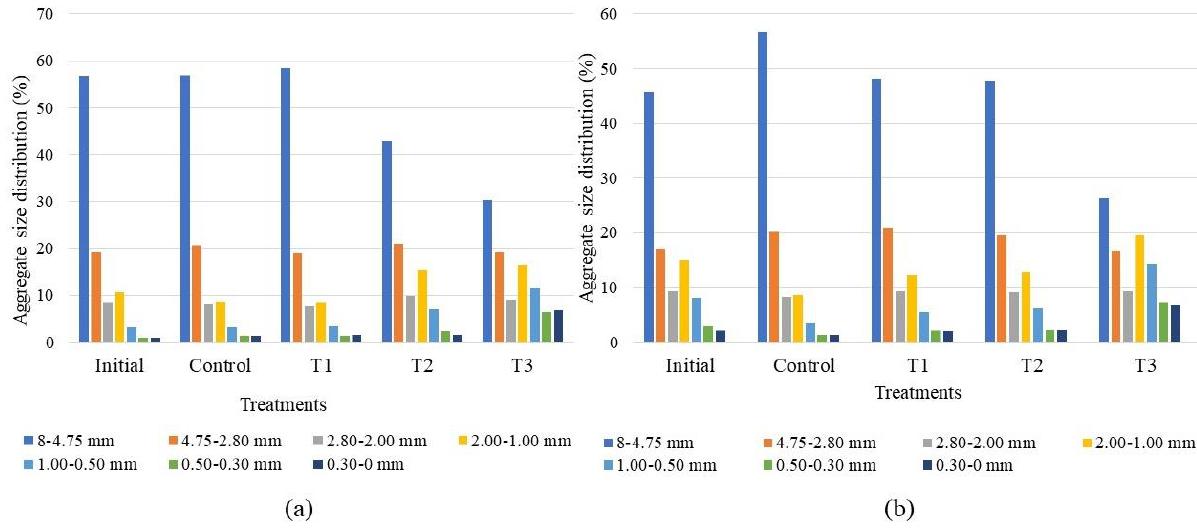
Figure 3. Distribution of aggregate size (%) in (a) hemic and (b) sapric peat materials in the initial and final weeks of the growing